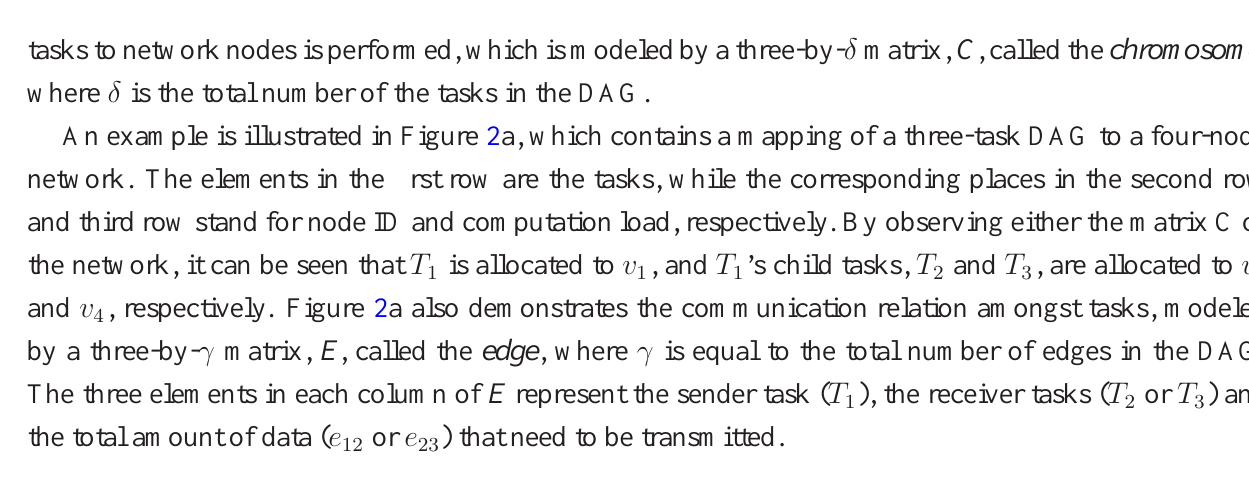
Figure 2. An example of the multi-hop extension